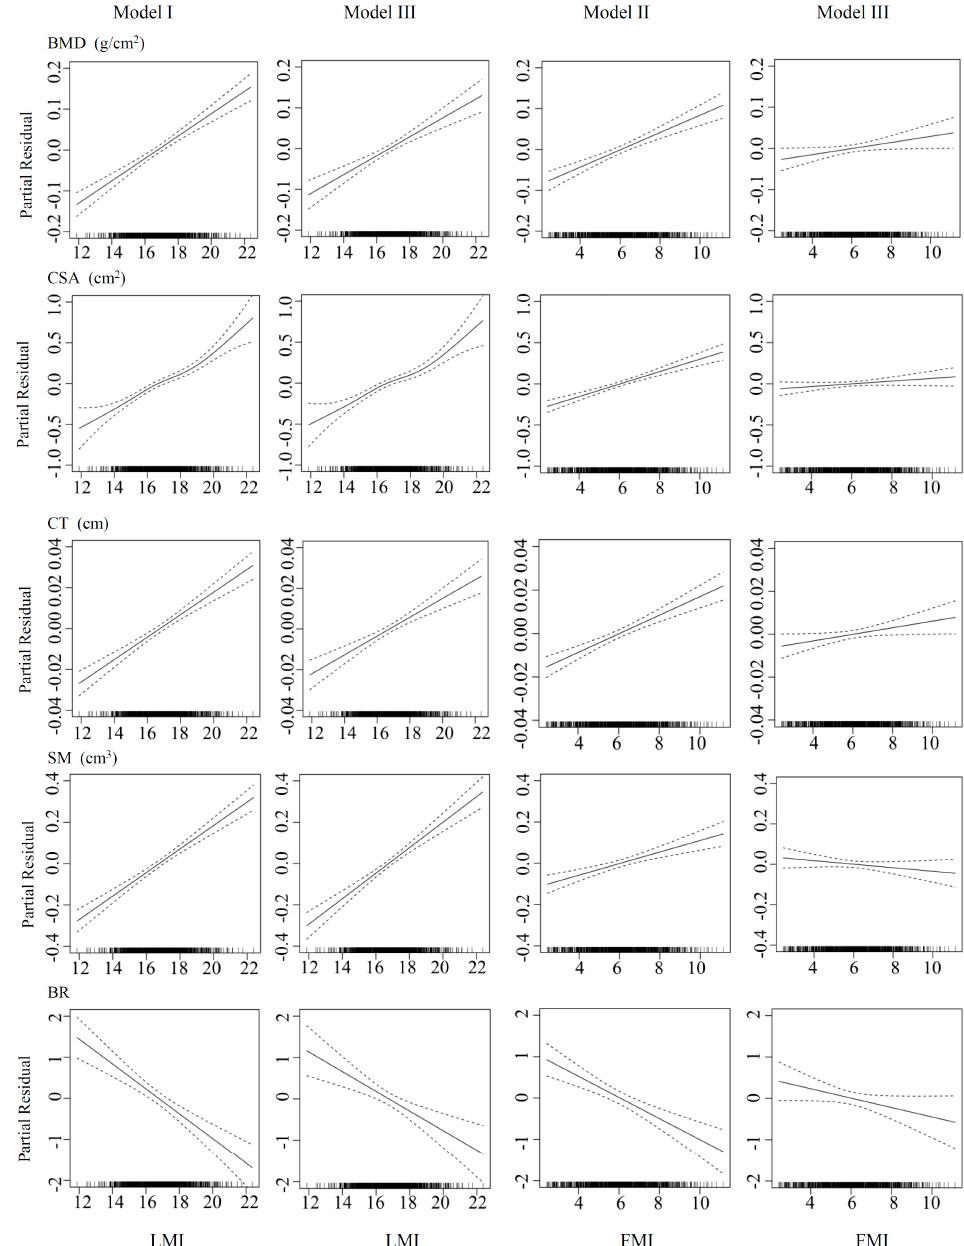
Figure 1. Associations between bone parameters and fat mass index (FMI, kg/m 2 ) or lean mass index (LMI, kg/m 2 ) using the generalised additive regression models. Dotted lines represent the 95% confidence intervals. The rug plot along the bottom of each graph depicts each observation. There were three models: I. Bone phenotype = f (LMI, covariates); II. Bone phenotype = f (FMI, covariates); III. Bone phenotype = f (FMI, LMI, covariates). Covariates included age, height, physical activity, smoking status, drinking status, calcium supplement intake, dietary calcium intake and dietary protein intake. BMD: bone mineral density; CSA: cross-sectional area; CT: cortical thickness; SM: section modulus; BR: buckling